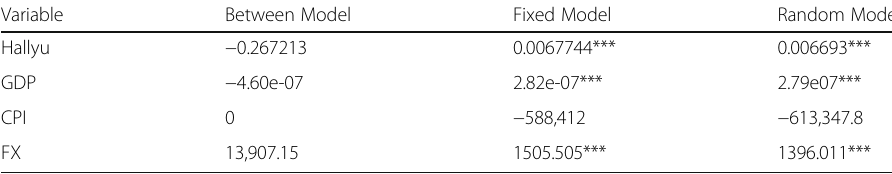
Table 3 Estimation coefficient of tourism demand forecast by each model Variable Between Model Fixed Model Random